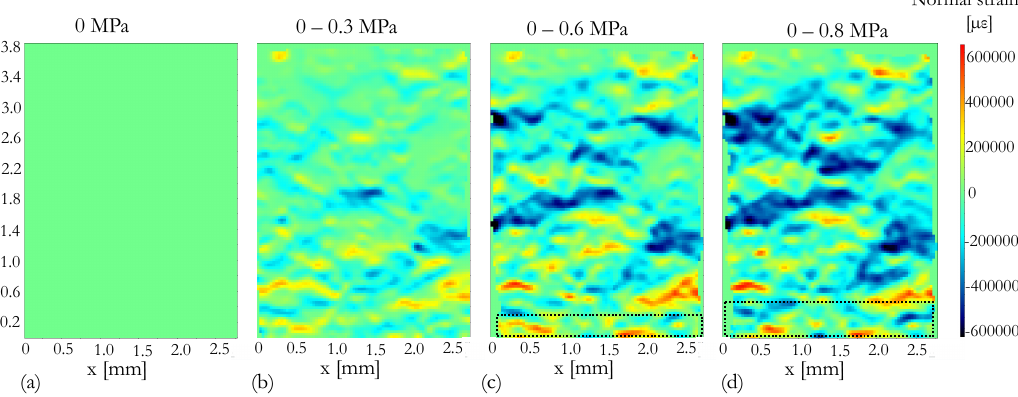
Figure 6. Normal strain fields with respect to the applied stress and dashed black lines in Figure 6c,d represent the moving punch. Figure 6a represents the strain field at unloaded state. Figure 6b,c,d represents the strain fields between unloaded state and loaded states 0.3 Mpa, 0.6 Mpa and 0.8 Mpa,